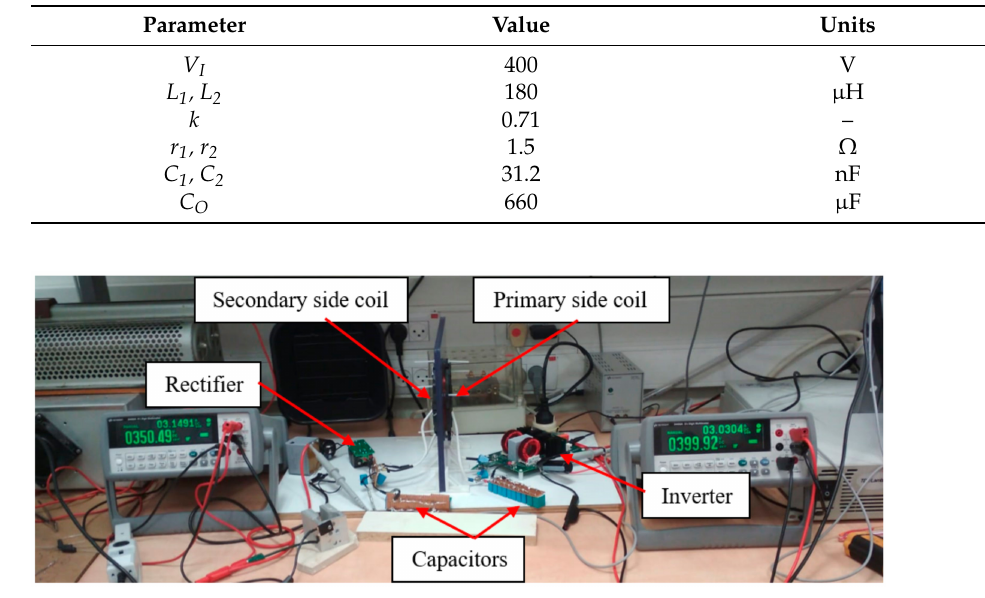
Figure 6. Experimental